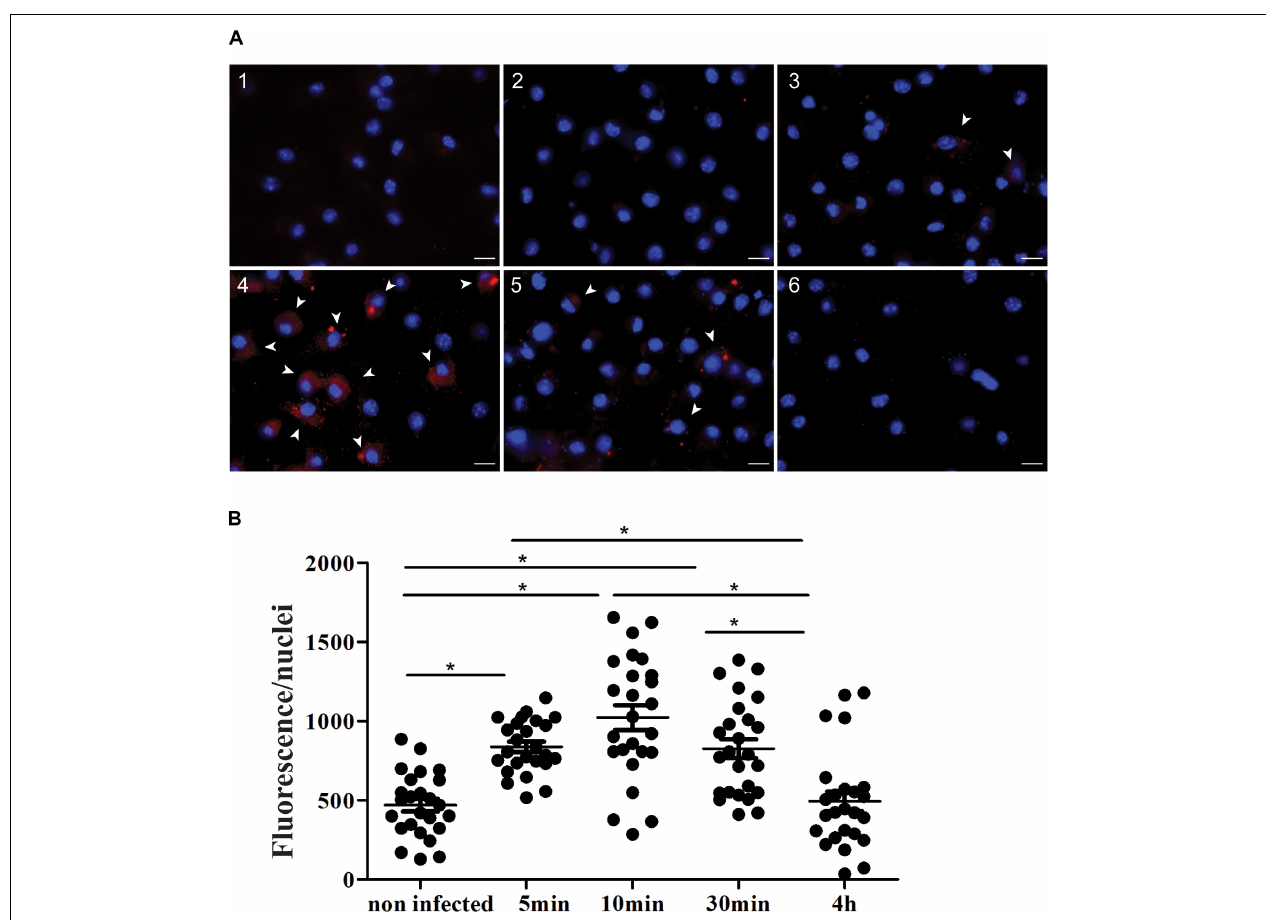
FIGURE 1 | Expression of CD100 in peritoneal macrophages infected or not with promastigotes of L. (L.) amazonensis . (A) Immunofluorescence staining for CD100 on infected and non-infected macrophages. Peritoneal macrophages from BALB/c mice non-infected (1 and 2), infected with promastigotes of L. (L.) amazonensis at MOI of 10:1 for 5 min (3), 10 min (4), 30 min (5), and 4 h (6). Staining with anti-CD100 antibody and secondary anti-rat Alexa Fluor 568 (red) and DAPI (blue nucleus). Control: DAPI (1) and secondary anti-rat Alexa Fluor 568 + DAPI (2). Images were captured in a DMI6000B/AF6000 (Leica) fluorescence microscope coupled to a digital camera system (DFC 365 FX). White bars correspond to 10 µ m. (B) Quantification of red fluorescence/nuclei in 25 fields for each condition. Statistical analysis by ANOVA with Tukey’s post-test, significant differences are labeled as ∗ p ≤